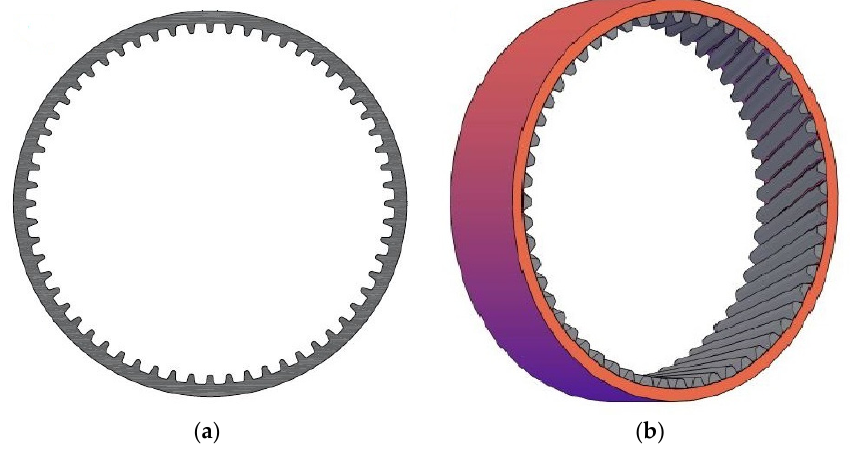
Figure 6. ( a ) 2D Micro-fin cross-sectional views; ( b ) 3D Micro-fin cross-sectional views.